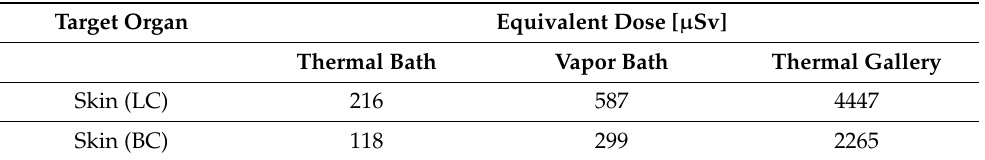
Table 5. Organ-specific equivalent doses for the Langerhans cells (LC) and basal cells (BC) in the epidermal layer of the skin, resulting from the attachment of radon progeny to the skin in the thermal bath, vapor bath, and thermal gallery.